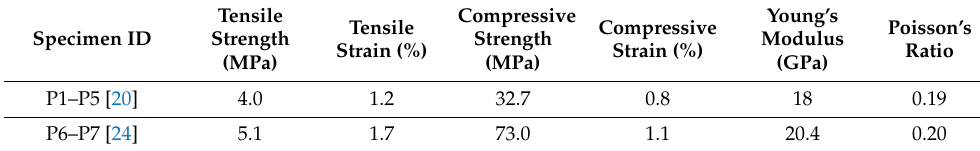
Table 2. Input parameters for ECC.